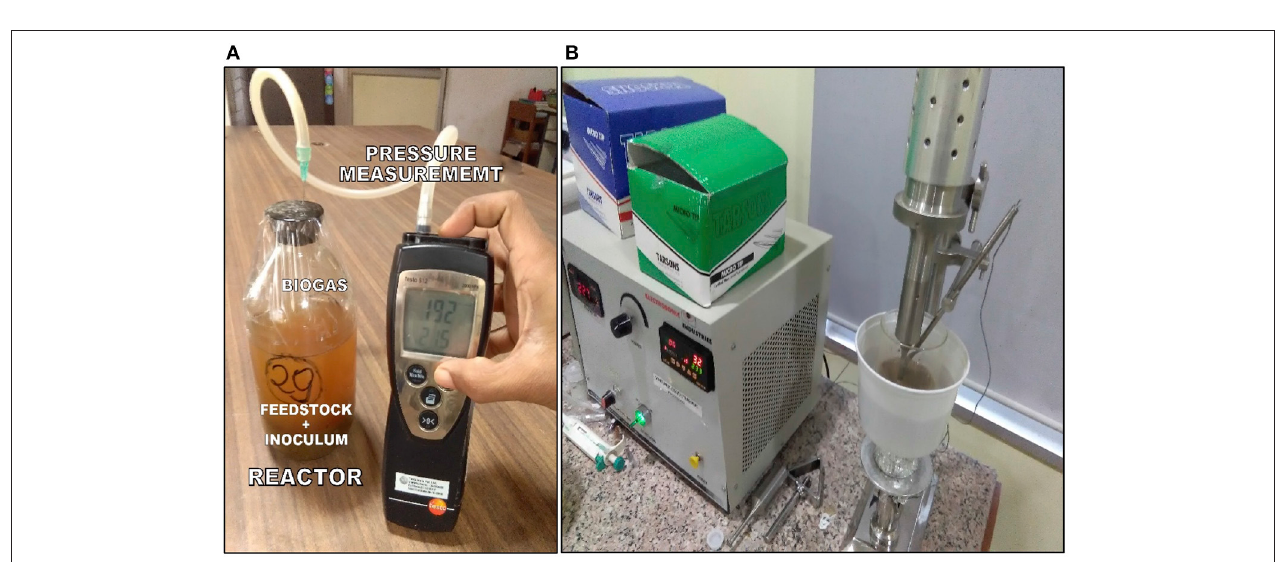
FIGURE 3 | (A) Digital pressure meter and (B) Ultrasonicator with probe and temperature sensor.